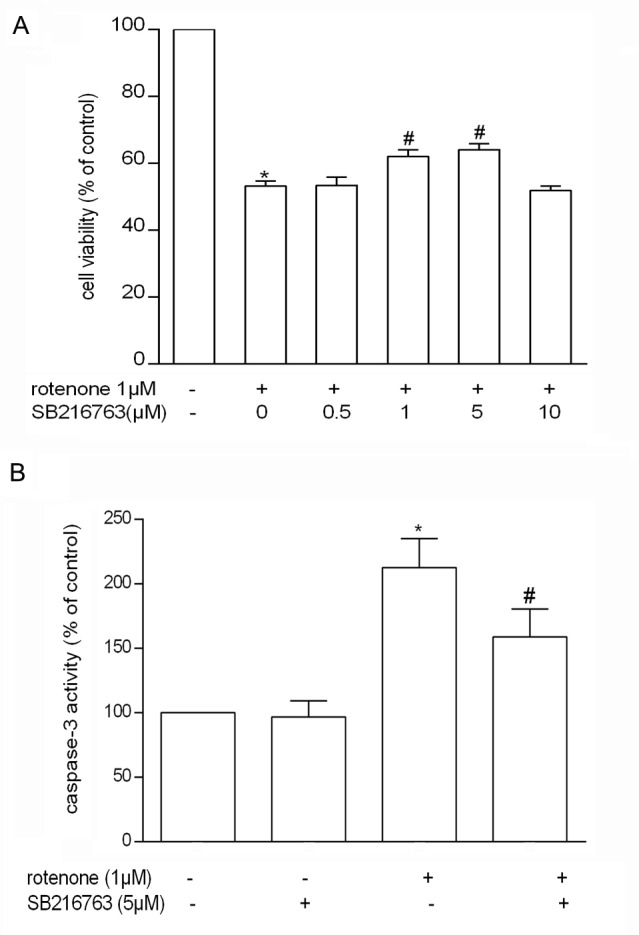
SB216763 activated Wnt/β-catenin pathway for the survival of PC12 cells.A. SB216763 attenuated rotenone-induced cell injury (*P< 0.05 compared to vehicle; #, P < 0.05 compared to rotenone). B. SB216763 inhibited the caspase-3 activity. Cells pretreated with 0~10 μM SB216763 in 30 minutes prior to 24 hours treatment of 1 μM rotenone. Caspase-3 activity was assessed by Caspase-3/CPP32 Fluor metric Assay Kit, and expressed as percentages relative to vehicle (n = 6 per group) (* P < 0.05; #P < 0.05 compared to rotenone treated group).